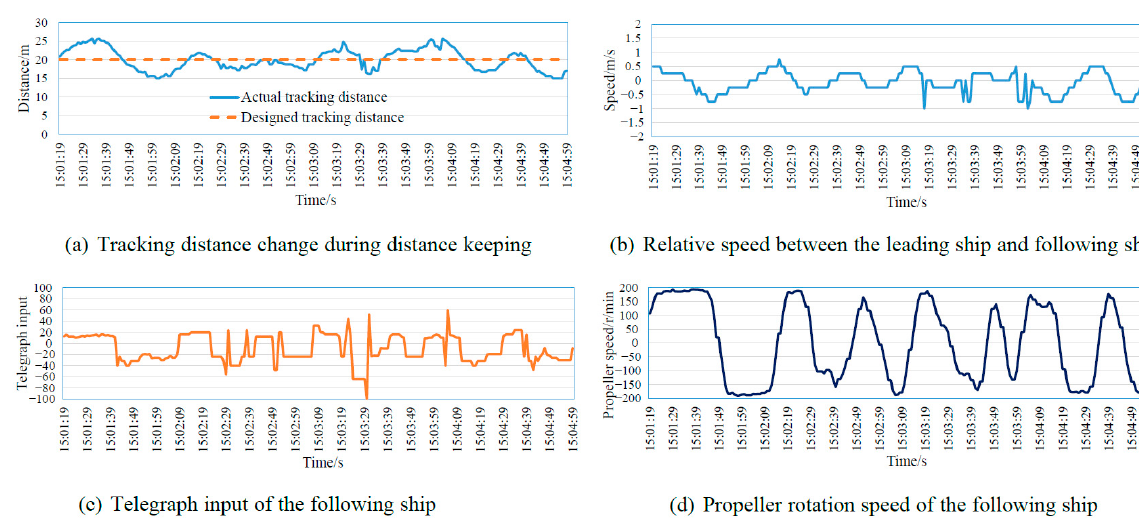
Figure 10. Distance-keeping control of the following ship.